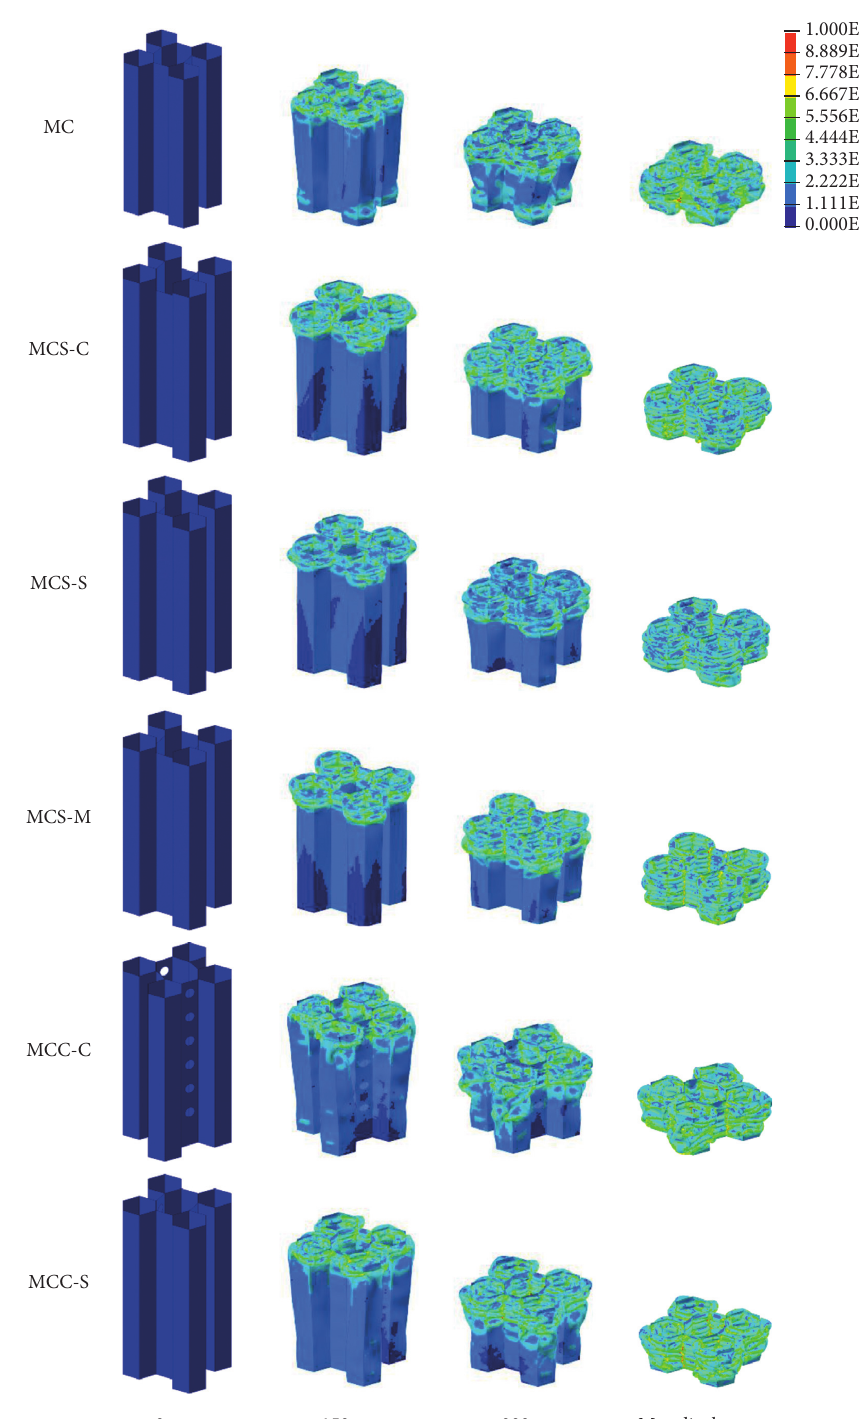
Figure 8: Finite element deformation models of the multi-cell